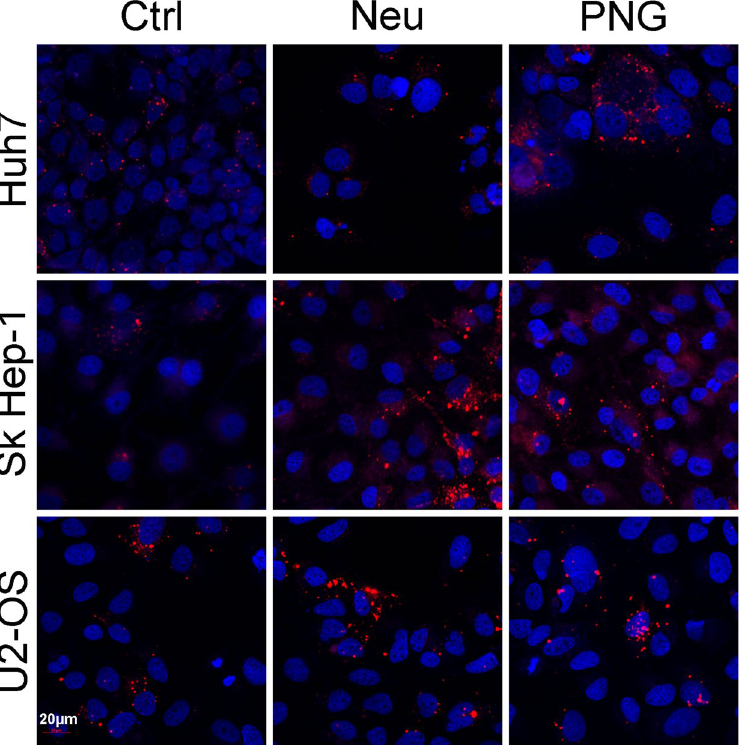
Figure 6. Confocal microscopy uptake analysis of glycosidase-treated AML12 EVs. Cells were incubated in the presence of DiI-labelled AML12 EVs for 16 hours. Confocal images of DiI (red) and DAPI (blue) dyes were taken at 20x magnification (20 µ m bar for